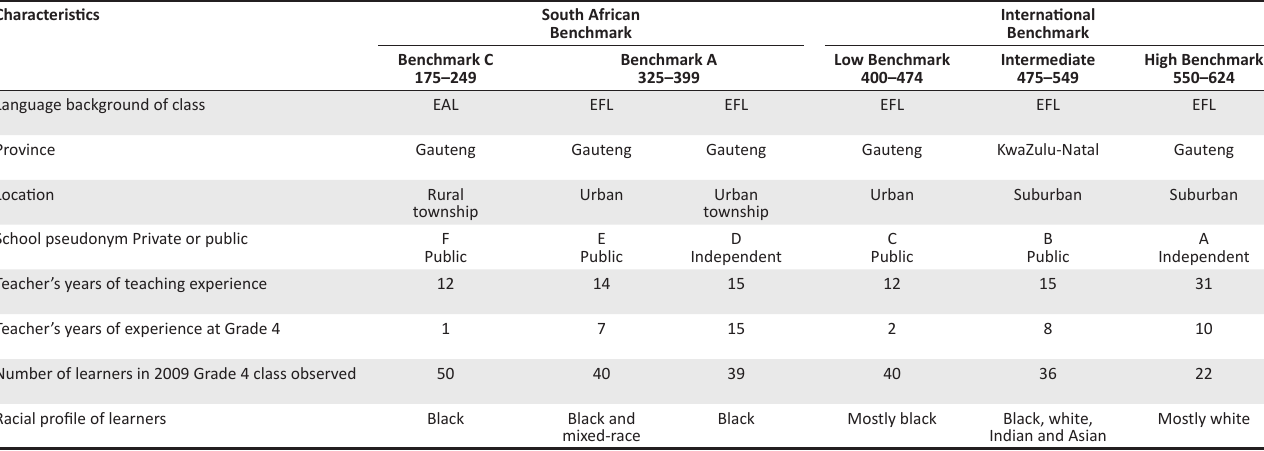
TABLE 2: School, class and teacher case characteristics.